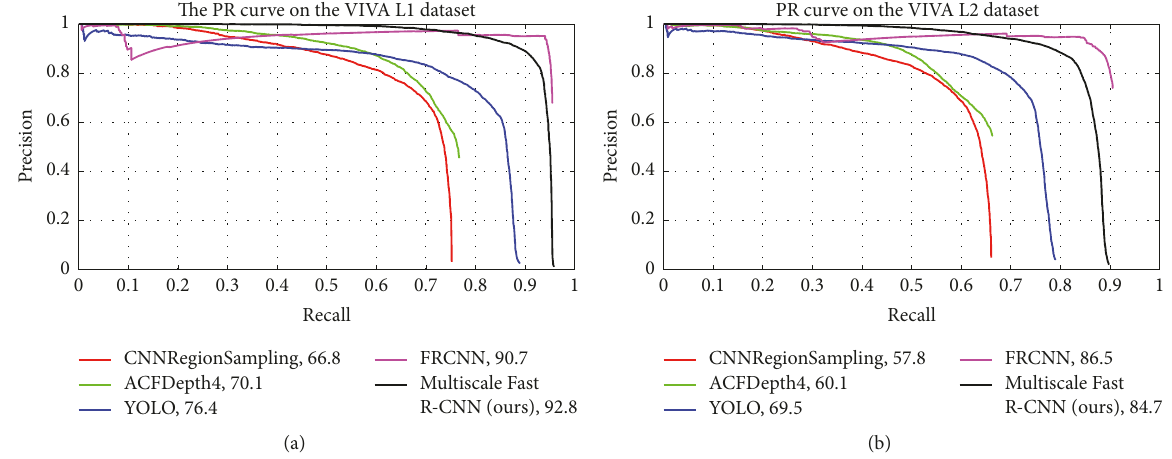
Figure 12: Precision-Recall curve on the VIVA hand detection dataset: (a) L1; (b) L2. The ROC curve of the VIVA L1 dataset The ROC curve of the VIVA L2 dataset